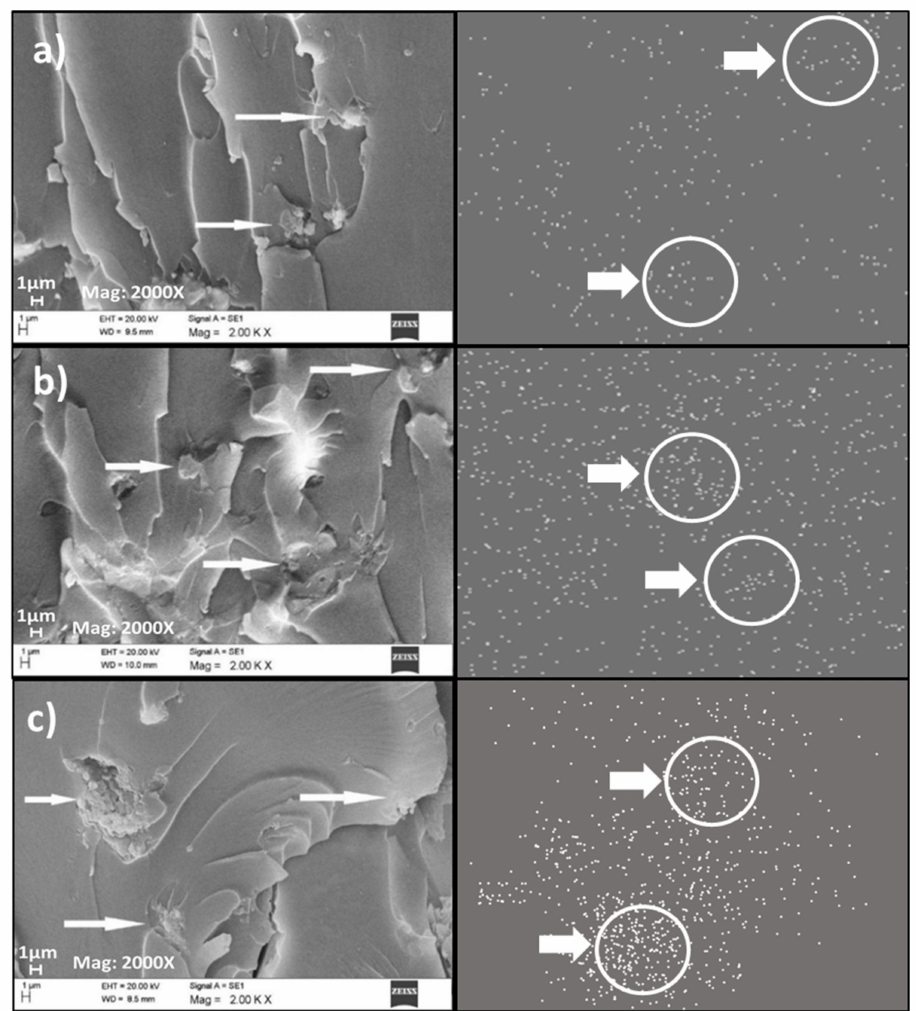
Figure 10. FESEM micrograph and elemental distribution mapping of ( a ) PF nanocomposite-filled 3% OPB nanoparticles, ( b ) PF nanocomposite-filled 4% OPB nanoparticles, and ( c ) PF nanocomposite-filled 5% OPB